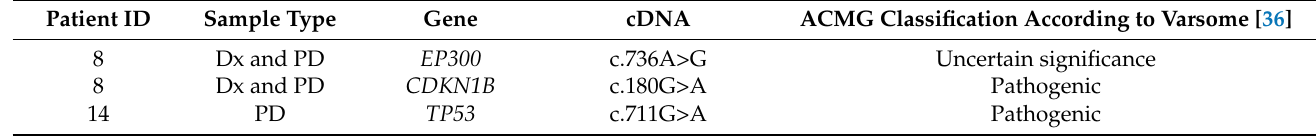
Table 2. Biallelic events detected in the first and paired